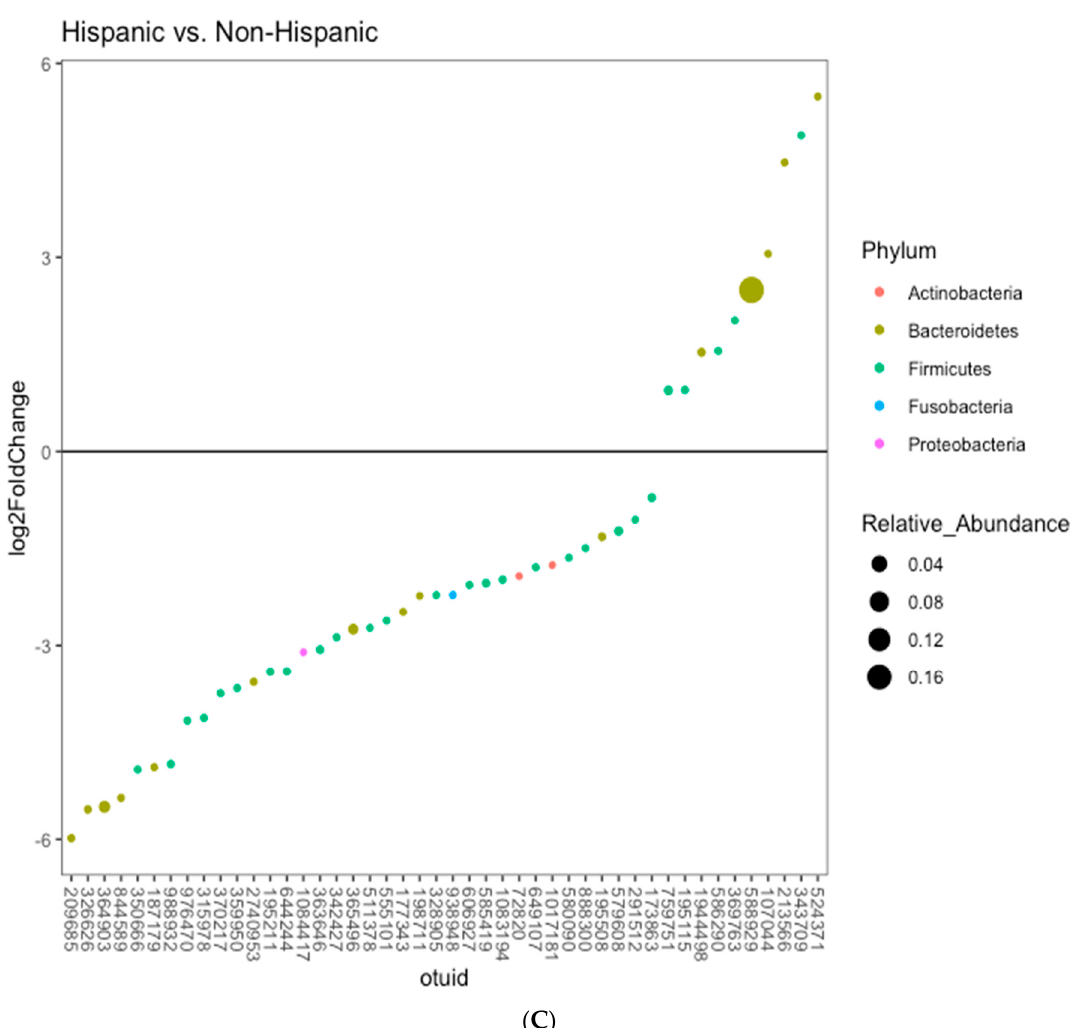
Figure 1. Microbial Profiles of Hispanic versus Non-Hispanic. ( A ). Beta Diversity. Principal coordinates analysis plots of microbial composition of Hispanic vs. Non-Hispanic. p -value is shown for the difference in root square Jensen-Shannon divergence distance matrix. ( B ). Alpha Diversity. Chao1 and Shannon Indexes illustrated in box plots of Hispanic vs. Non-Hispanic. ( C ). Differential expression of microbial genera (Phylum: (Genus)) associated with Hispanic vs. Non-Hispanic. Positive log2 fold change favor association to Hispanics in the following microbiome: Bacteroidetes : 107,044 ( Alistipes ), 524,371 ( Prevotella ), 1,944,498 ( Bacteroides ), 588,929 ( Prevotella ), 213,566 ( Bacteroides ).